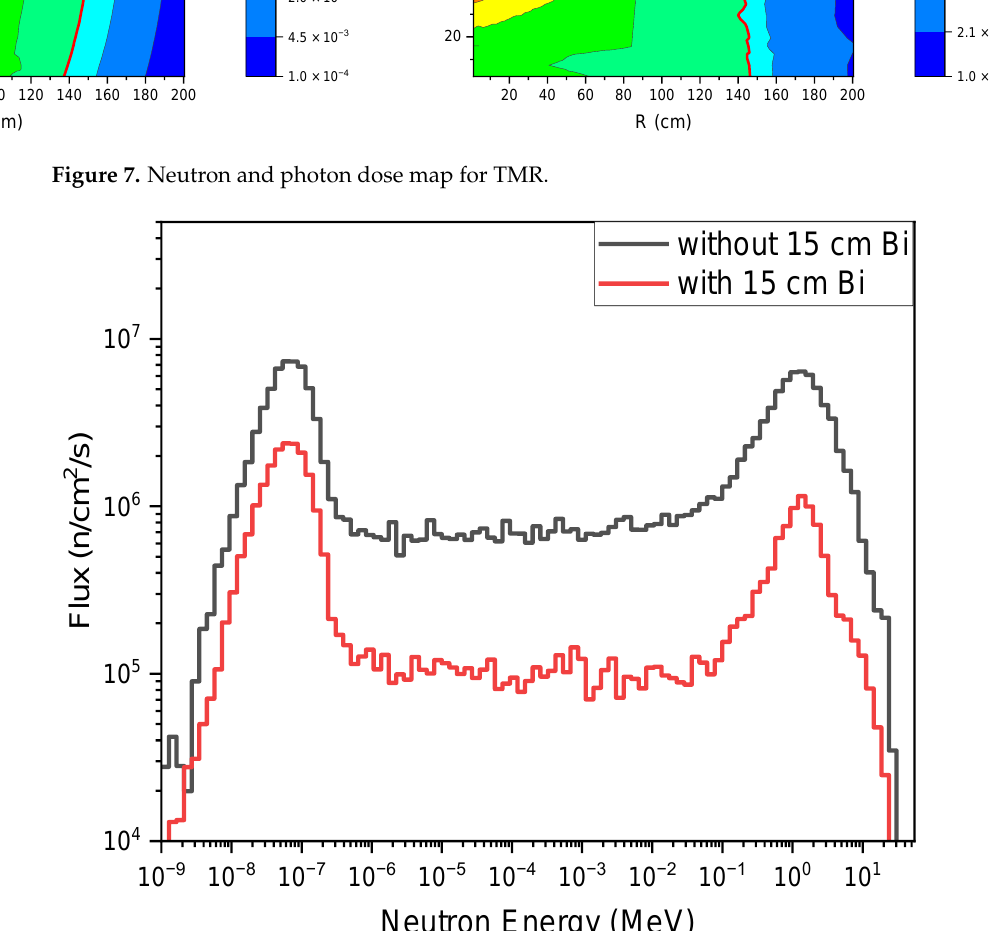
Figure 8. Neutron spectra at the end of the exit channel with or without 15 cm bismuth.